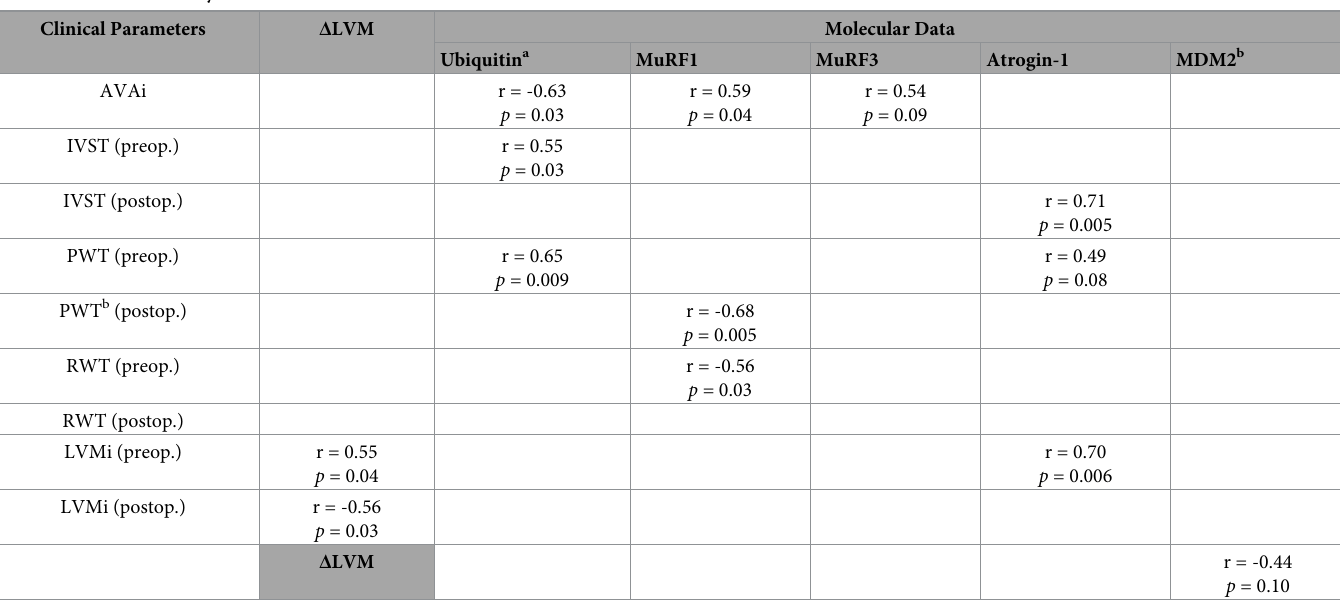
Table 3. Correlation analysis between clinical and molecular data. Clinical